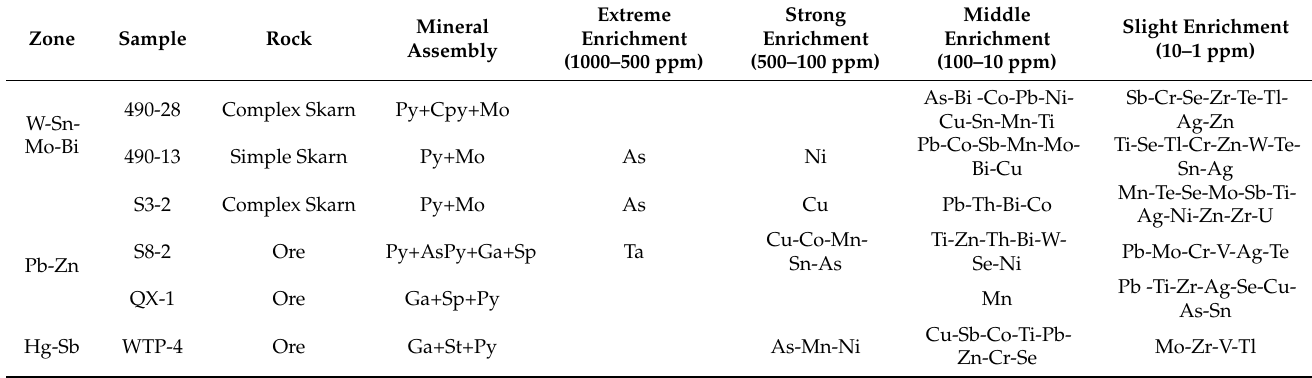
Table 2. Trace element characteristic of pyrites from the Shizhuyuan